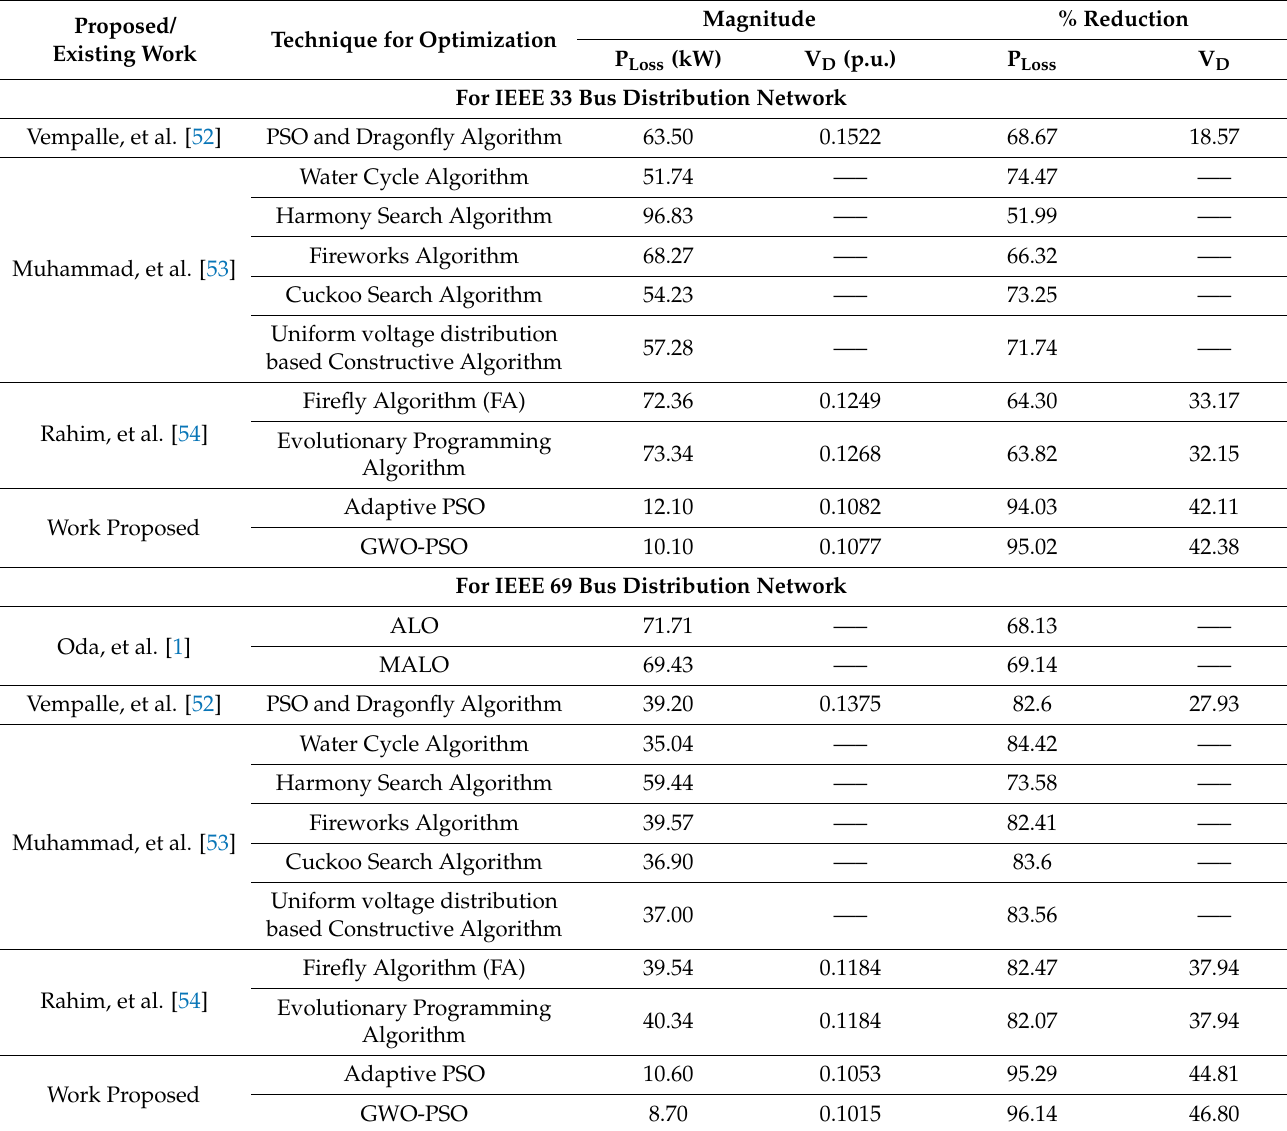
Table 14. The comparative analysis of the proposed work with existing work on 33- and 69-bus